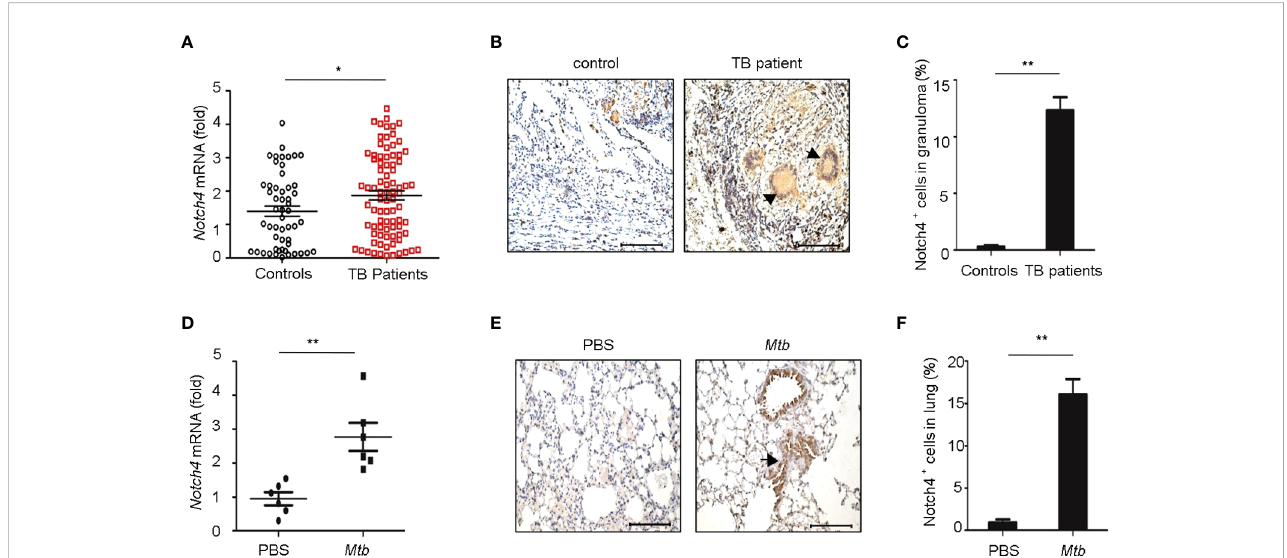
FIGURE 2 Elevated Notch4 expression in tuberculosis patients. (A) qRT-PCR detection of Notch4 expression in PBMCs from 53 healthy individuals and 84 TB patients. (B, C) Representative immunostaining of Notch4 in granulomas from 5 TB patients (B) and quanti fi cation of Notch4 positive cells (C) . Bar, 100 µm. Magni fi cation: ×200. (D) qRT-PCR of Notch4 mRNA in lungs of mice aerosol-infected with ~200 CFU Mtb H37Rv for 4 weeks (6 mice/group). (E, F) Representative immunostaining of Notch4 in lungs of mice infected as in E (E) and quanti fi cation of Notch4 positive cells (F) . Bar, 100 µm. Magni fi cation: ×200. The representative images were shown (B, E) . Results shown in (A, C, D, F) were expressed as mean ± SEM by the Student t test, * P < 0.05 and ** P < 0.01.